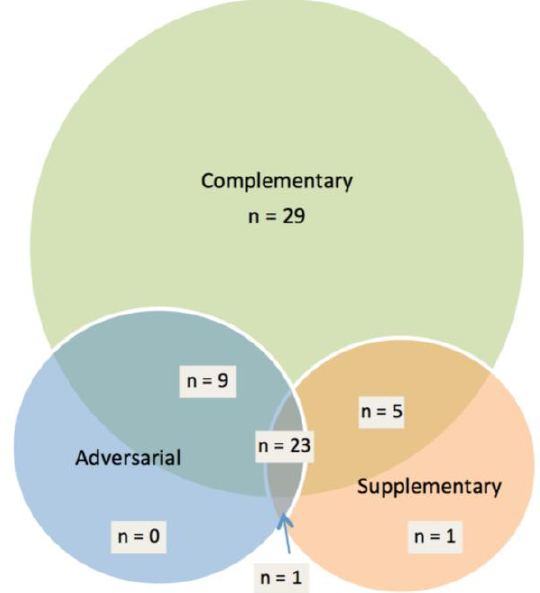
Figure 3. Mix of activities to be planned, by type, in